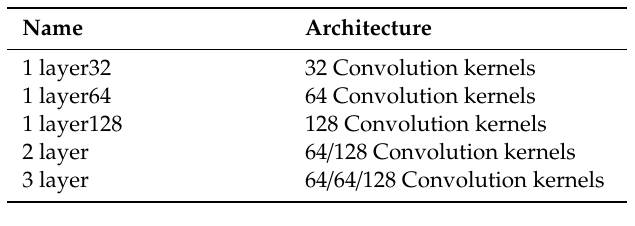
Table 2. CNN structure.